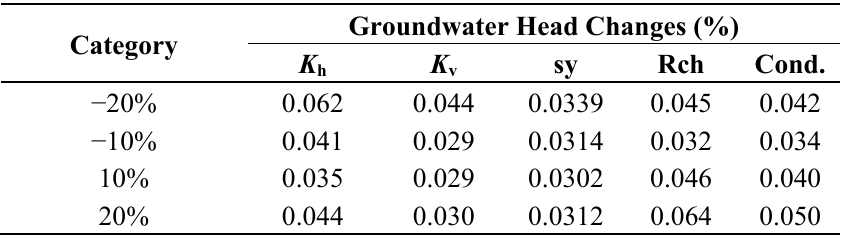
Table 2. Groundwater head changes versus the changes of different